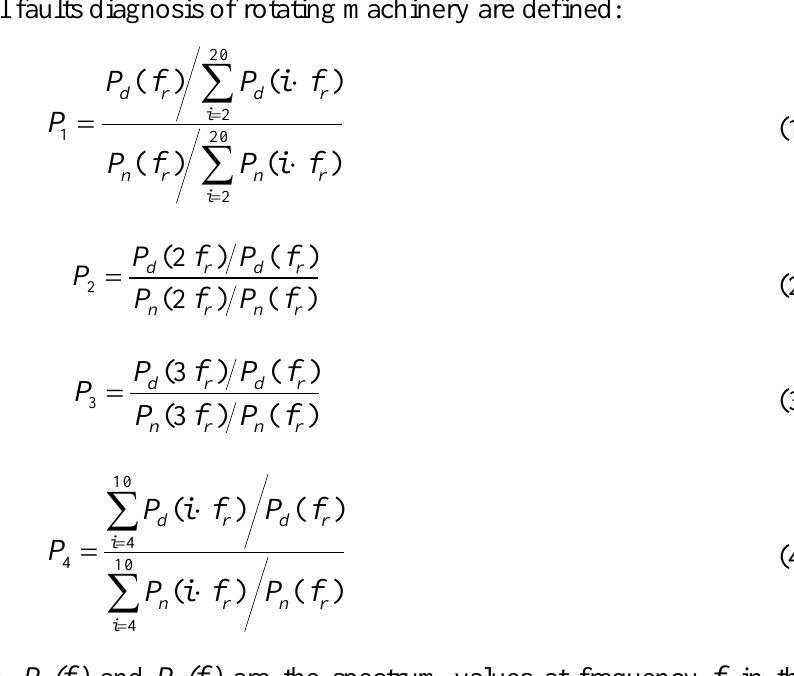
the ACO with the selected